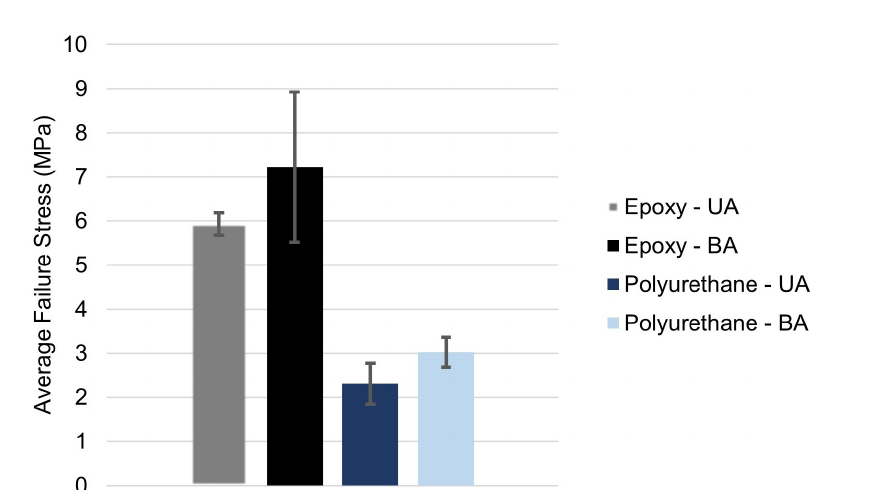
Figure 7. Average failure stress according to the parameters of adhesive type and surface